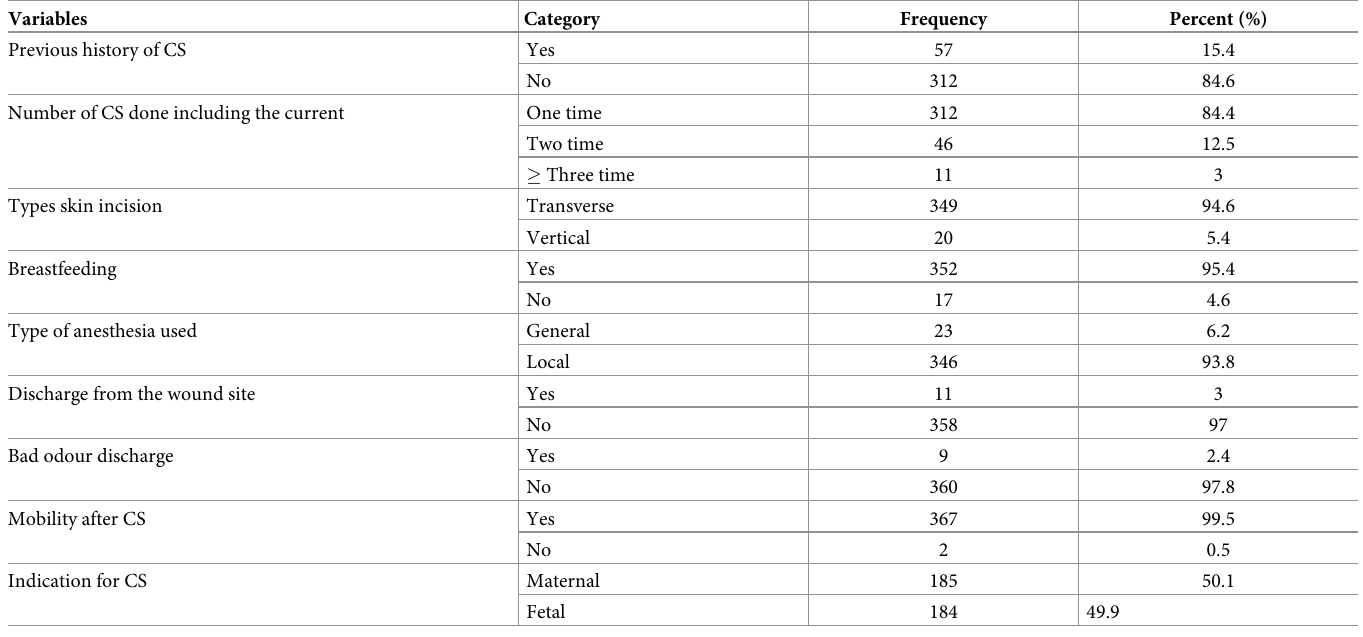
Table 3. Pre, intra and post-operative characteristics of the women on predictors of time-to-recovery from cesarean section delivery among women who gave birth by CS at HUCSH, 2020 (n = 369). Variables